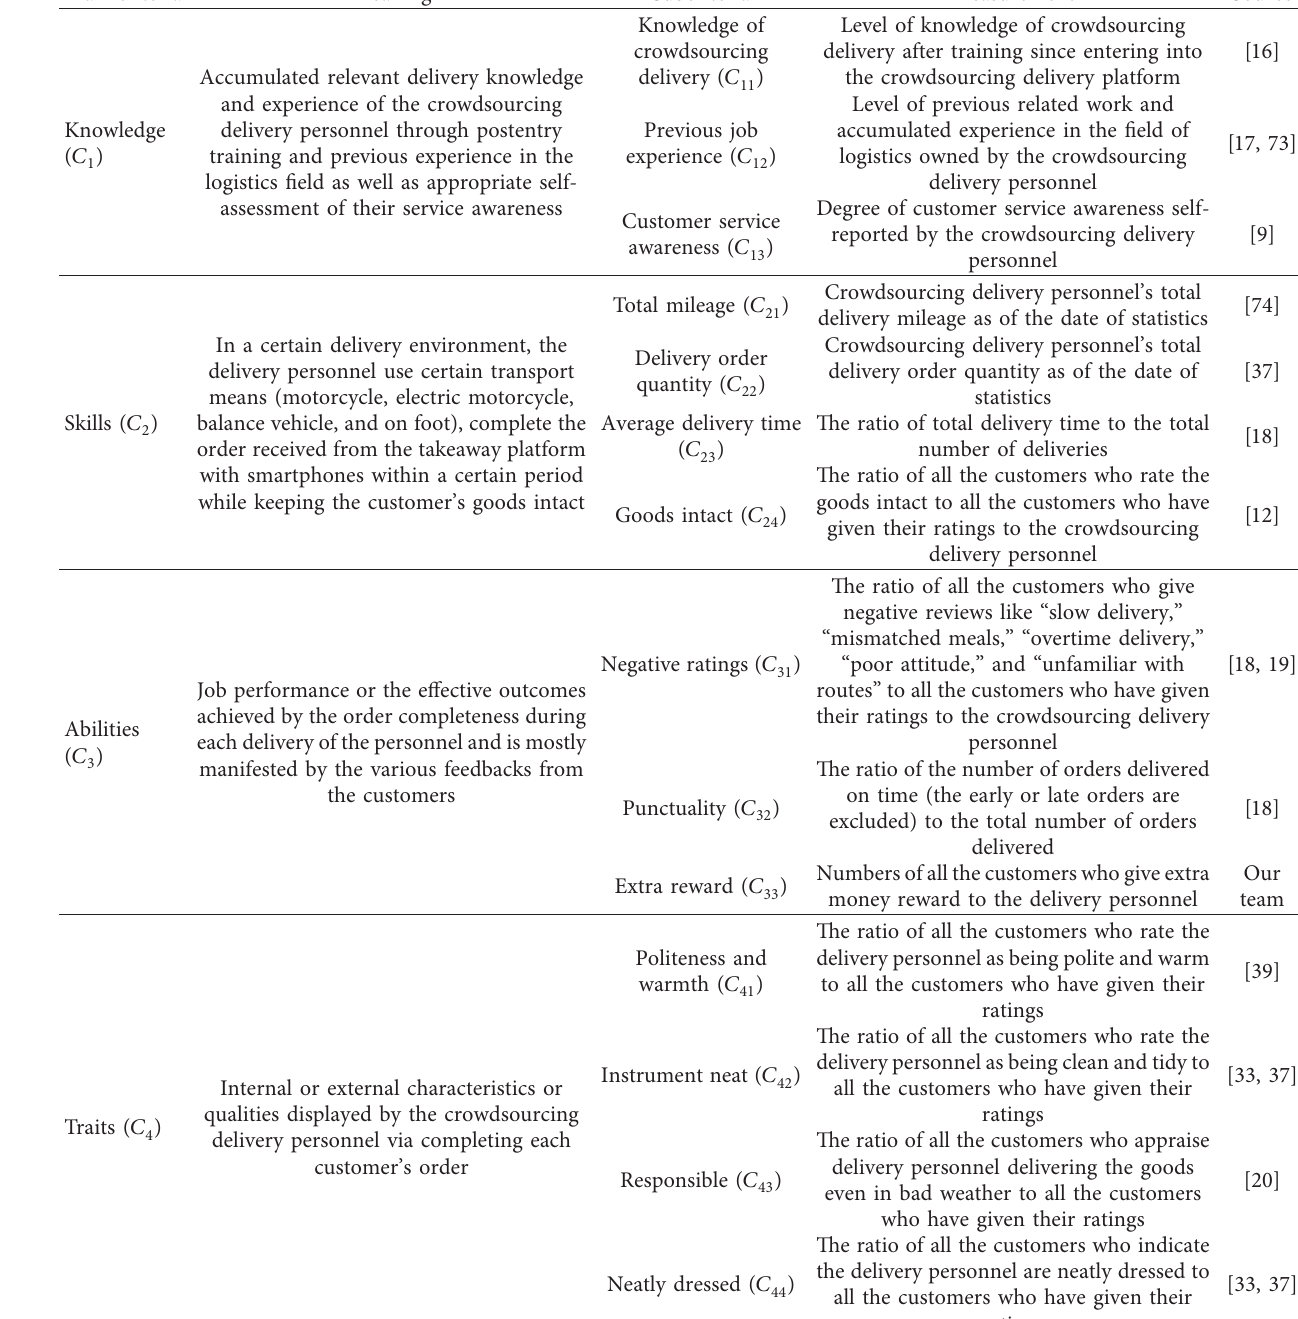
Table 2: MCCA framework for the crowdsourcing delivery